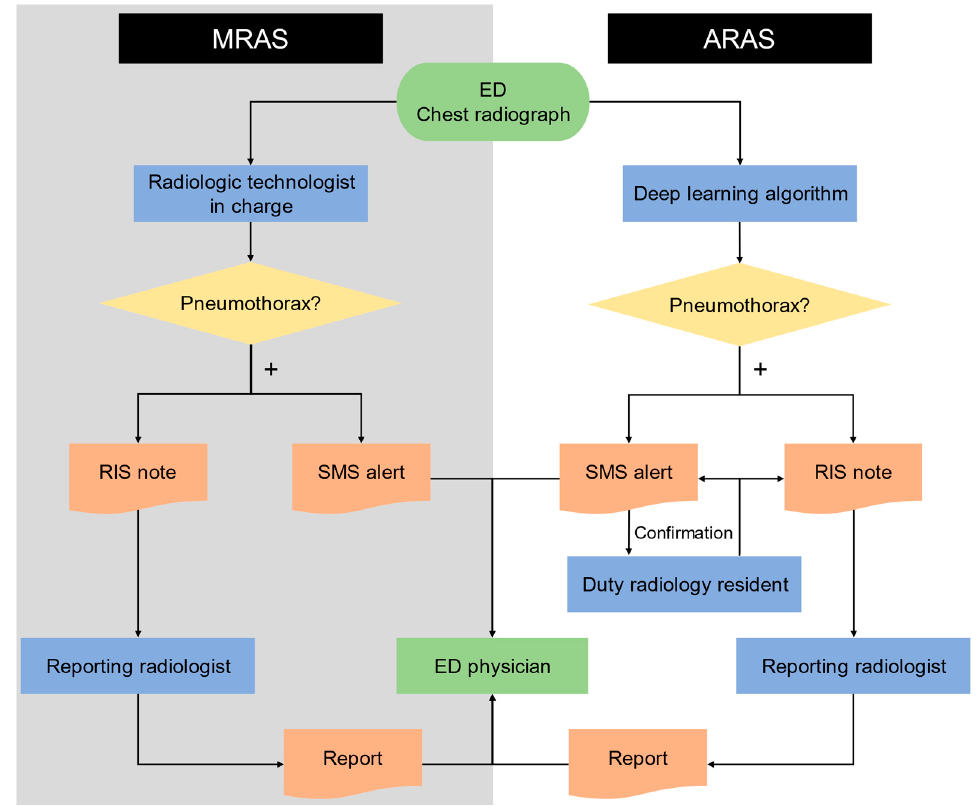
Figure 3. The flow charts of the manual radiology alert system and the automated radiology alert system. Abbreviations: MRAS, Manual Radiology Alert System; ARAS, Automated Radiology Alert System; SMS, Short Message System; RIS, Radiology Information System.